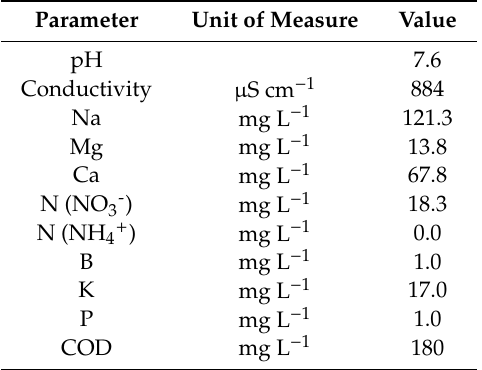
Table 1. Chemical parameters of treated municipal